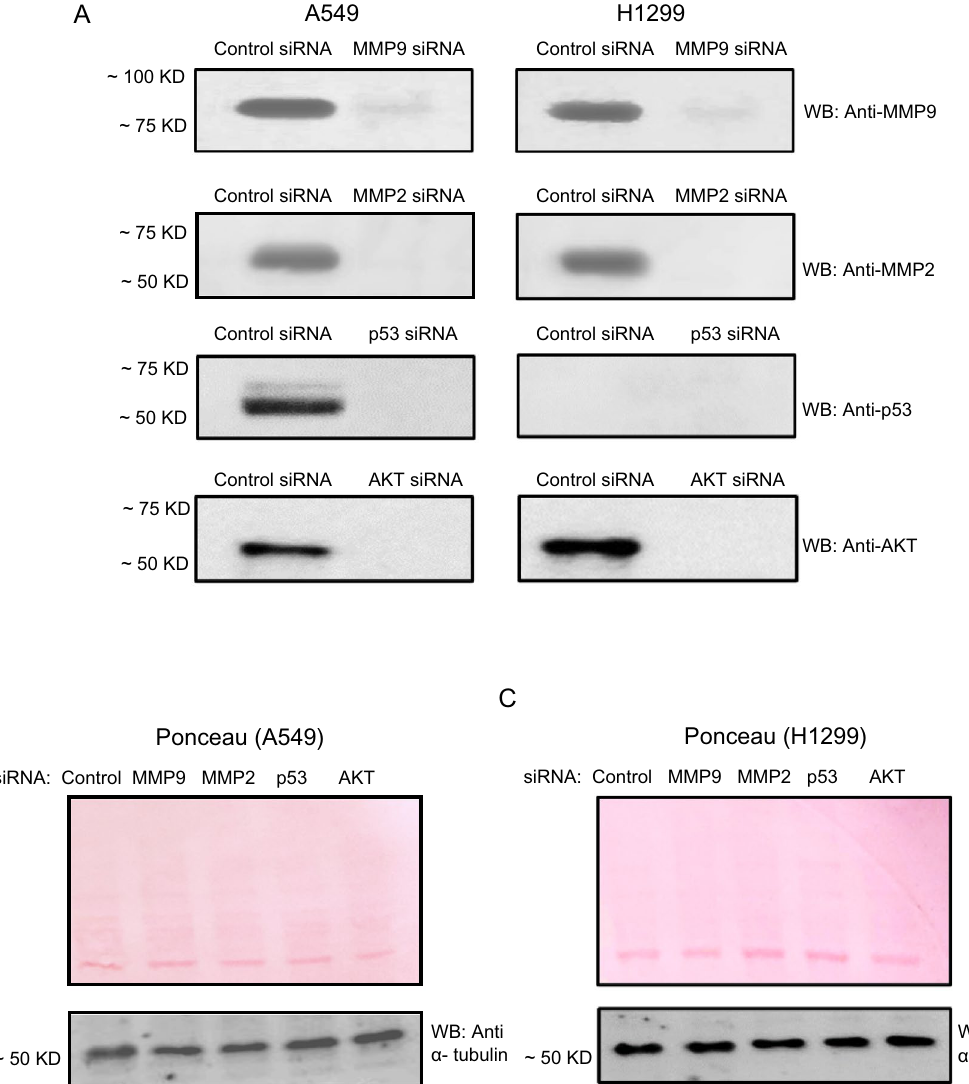
Figure 7. Knockdown of MMP9, MMP2, p53, and AKT by siRNA transfection. Cells were seeded at a density of 2 × 10 4 cells in 25 cm 2 flasks. The following day, siRNA targeted against the indicated proteins was mixed with Lipofectamine 2000 transfection reagent (ThermoFisher) for 20 min at RT. The mixtures were then added to the cells to a final concentration of 100 nM for each siRNA. The cells were then allowed to incubate at 37 °C in serum-free media for 72 h. The same concentration of total protein (15 µL of 600 µg/mL) of the cell lysates ( A ) was used for Western blotting using the indicated antibodies. Total protein (Ponceau staining) and α-tubulin ( B , C ) served as loading